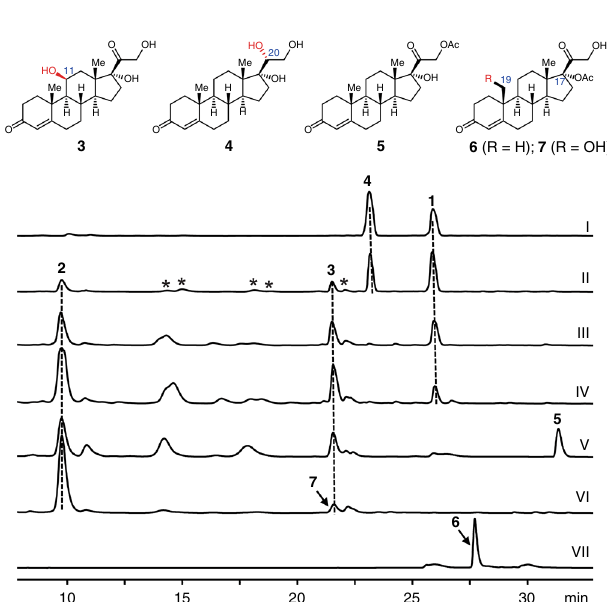
Fig. 2 Production of hydroxylated cortexolones using A. oryzae-tcP450-1 and T. cucumeris . (I) A. oryzae integrated with empty vector pTAex3, fed with 1 ; (II) A. oryzae-tcP450-1 , fed with 1 ; (III) T. cucumeris under the conditions described 31, 32 , fed with 1 ; (IV) T. cucumeris with the optimized condition, fed with 1 ; (V) T. cucumeris , fed with 5 ; (VI) T. cucumeris , fed with 6 ; (VII) standard 6 . Samples were taken and analyzed at the fi fth day (for A. oryzae ) and third day (for T. cucumeris ) after substrates were fed. Peaks with